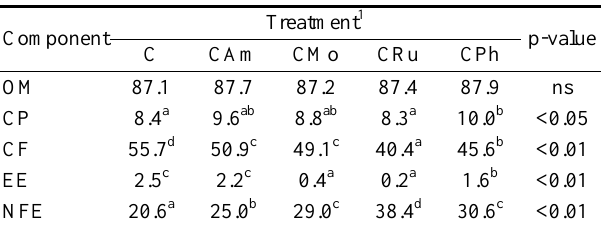
Table 1. Influence of various chemical and biological treatments on proximate composition of cocoa pod Component